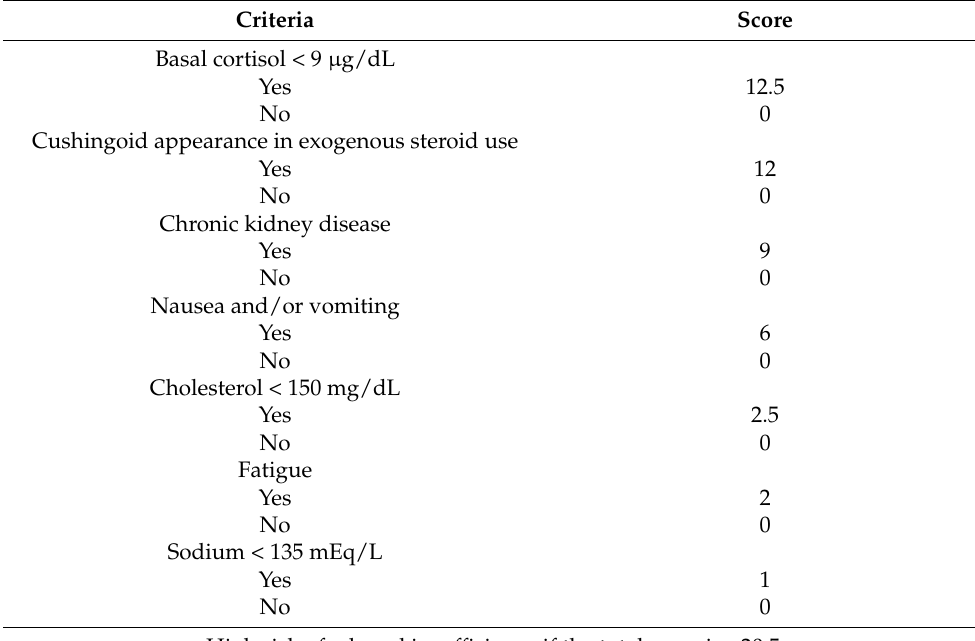
Figure 2. Score-predicted risk (line) and actual risk (circles) of adrenal insufficiency for each total score (the size of the circle indicates the number of patients). Table 3. Risk score for the diagnosis of adrenal